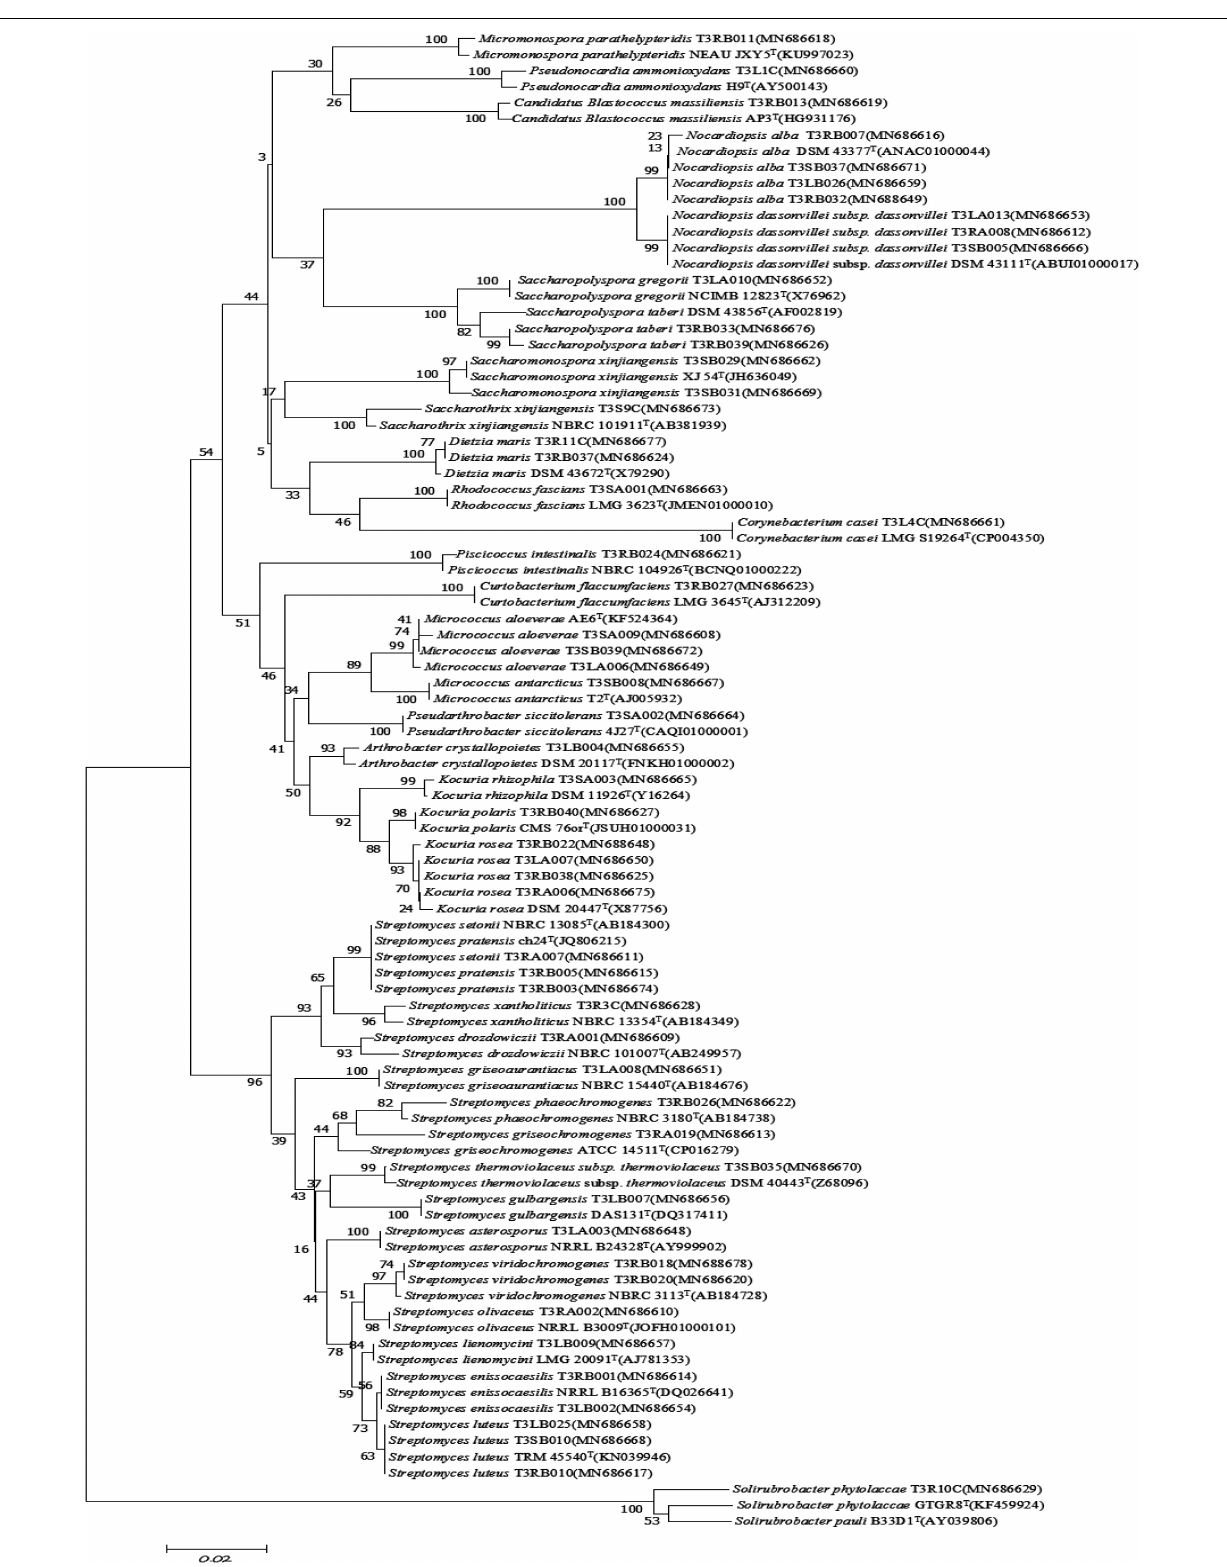
Frontiers in Microbiology |